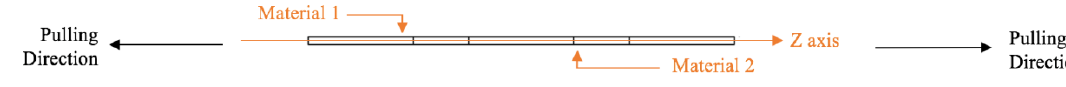
Figure 7. Modelling X-axis combination as iso-strain.